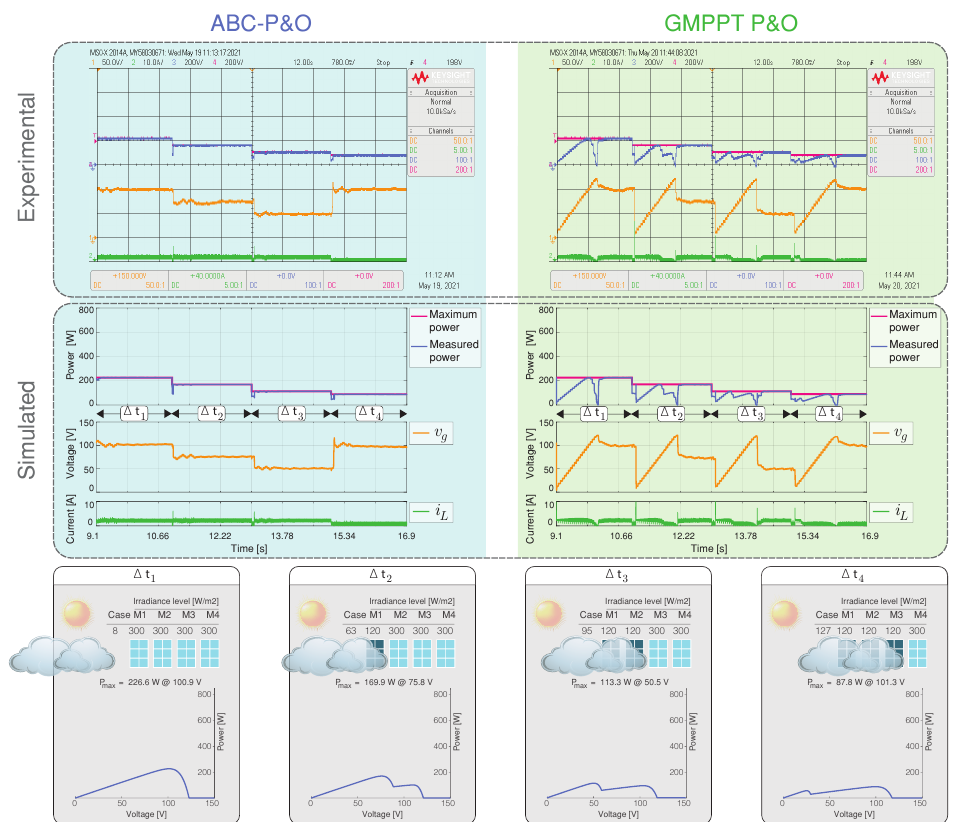
Figure 17. Simulated and experimental dynamic behavior of the MPPT algorithms for Scenario 6 with an output voltage V o = 160 V. The proposed MPPT algorithm (right) is compared with the GMPPT P&O algorithm (right). CH1: v g (50 V/div), CH2: i L (10 A/div), CH3: maximum power (200 W/div), CH4: measured power (200 W/div), and a time base of 780 ms. RE MAE